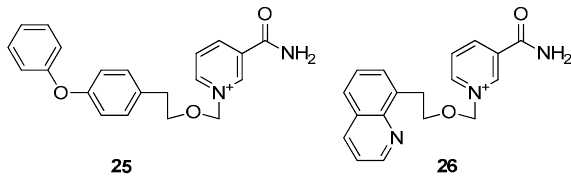
Figure 5. Inhibitors of CD38 NADase activity showing muscle relaxation effect [56].